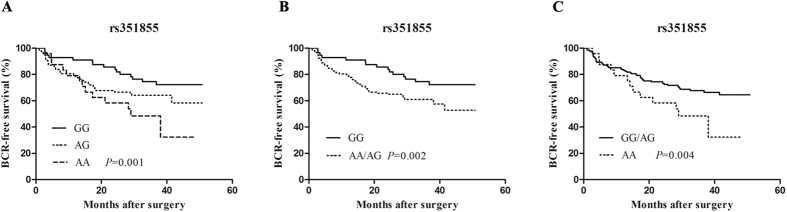
Kaplan-Meier survival analysis for BCR-free survival after radical prostatectomy according to FGFR4 rs351855 genotypes.(A) Three genotypes (B). Recessive model (C). Dominant model.